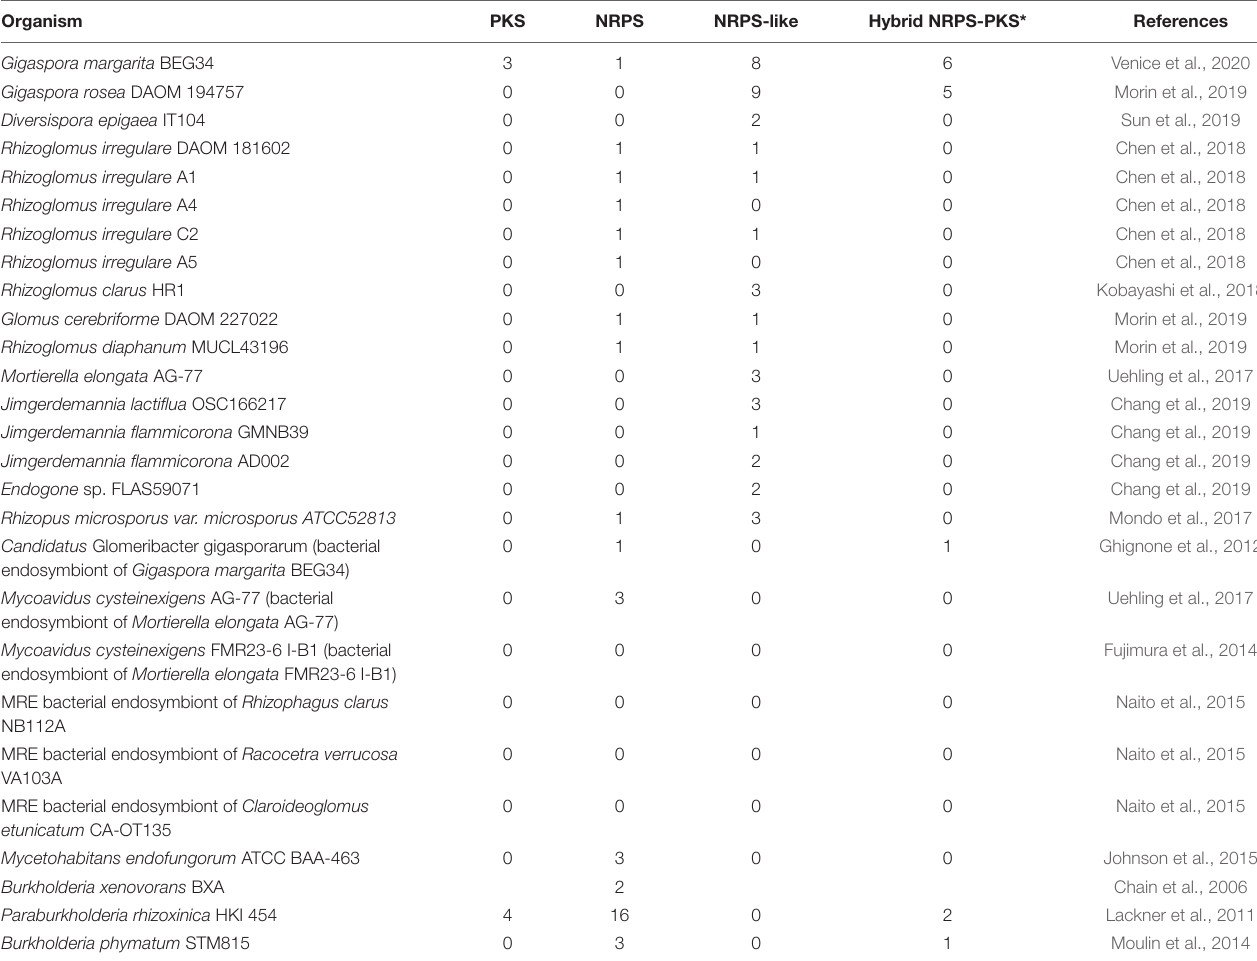
TABLE 1 | PKS, NRPS/NRPS-like, and NRPS-PKS content in the sequenced genomes of Glomeromycotina and their relatives from Mucoromycota. The same screening was carried out for bacterial endosymbionts of Mucoromycota which genome is available. Reference studies for the analyzed genomic sequences are shown. Organism PKS NRPS NRPS-like Hybrid